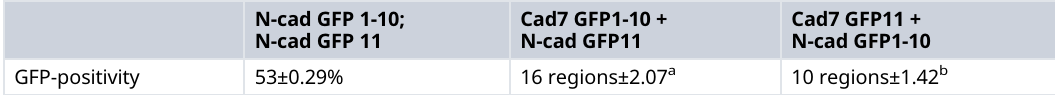
Table 2. Electroporation efficiency of Cadherin split GFP plasmids.